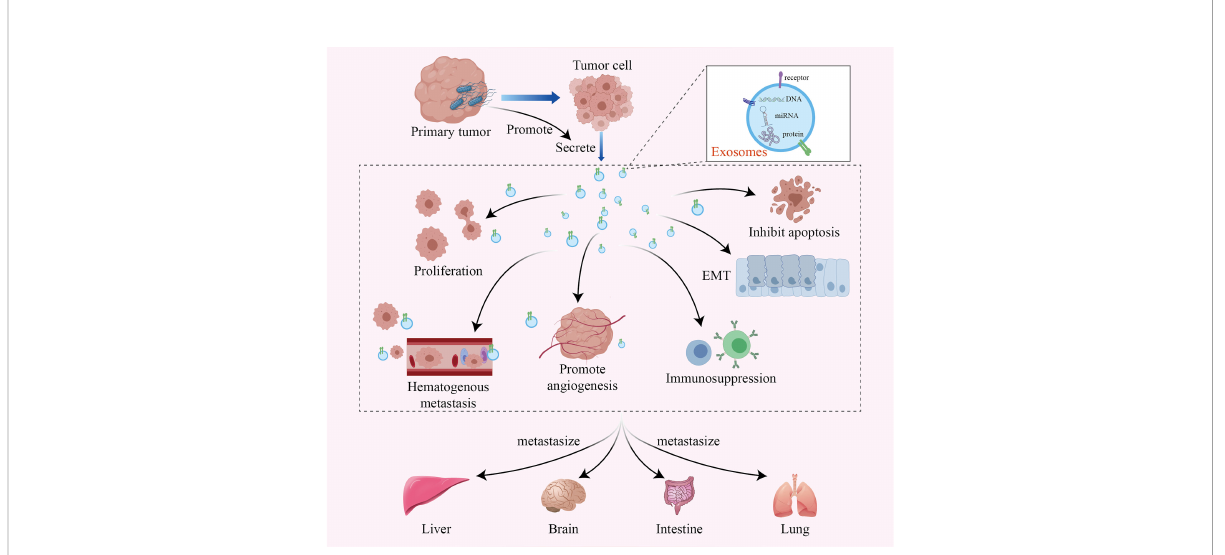
FIGURE 2 The intratumoral microbiome promotes tumor metastasis by facilitating the production of tumor-derived exosomes. Exosomes are active vesicles carrying various DNAs, miRNAs and proteins. The intratumoral microbiome can cause infected tumor cells to secrete more exosomes, which promote tumor metastasis through various mechanisms, such as remodeling the tumor microenvironment, promoting tumor cell proliferation and inhibiting apoptosis, promoting epithelial-mesenchymal transformation, inhibiting the antitumor immune response, and promoting hematological tumor metastasis and